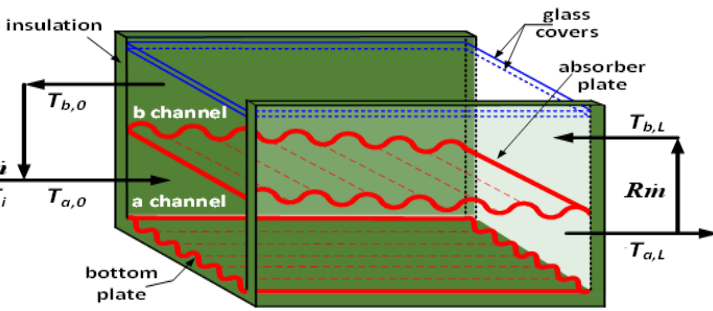
Figure 2. Schematic drawing of a recycling double-pass cross-corrugated solar air heater (Type A).